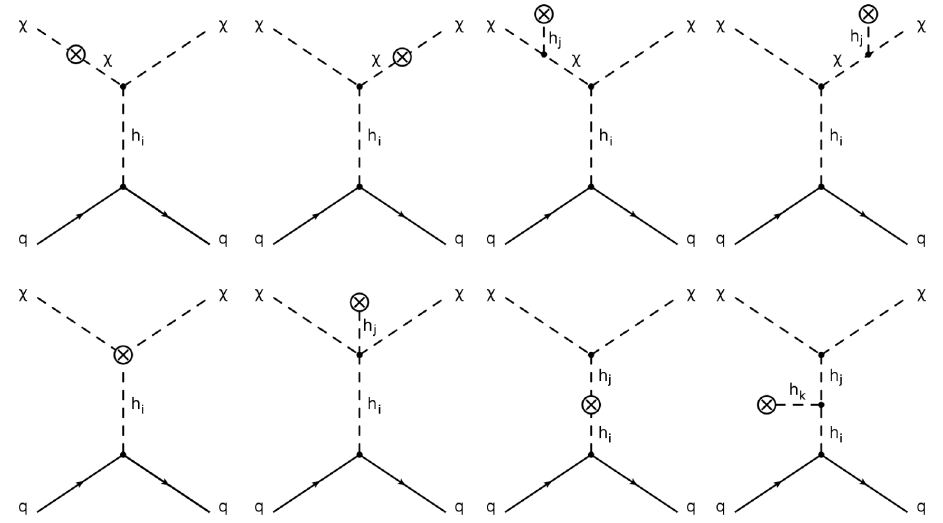
Figure 2 . Counter-term insertion diagrams for the DM-nucleon scattering ( i, j ∈ { 1 , 2 , 3 } ).